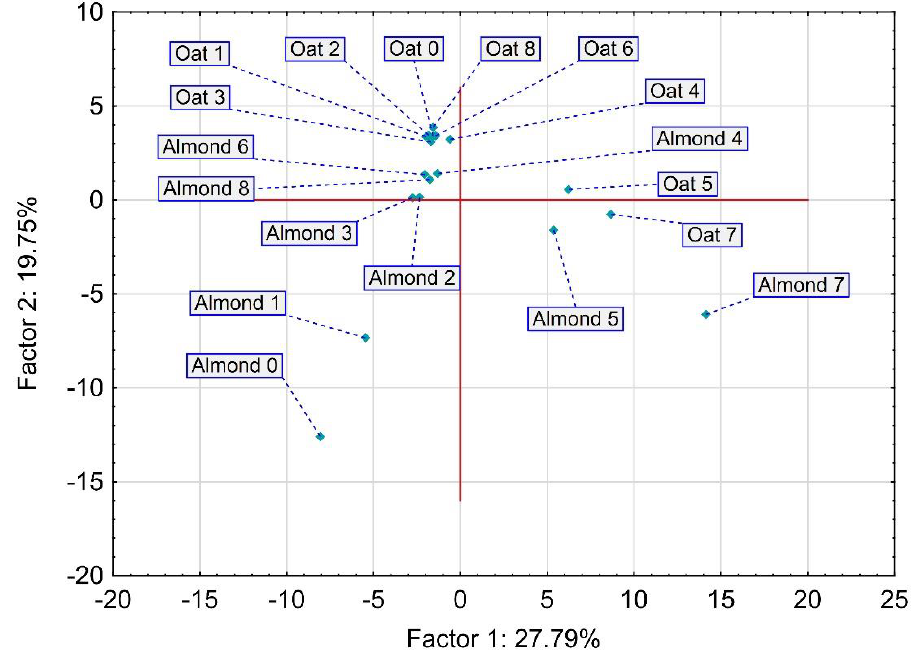
Figure 1. Score plot for principal component analysis (PCA) applied to the volatile compounds of almond and oat beverages (0 — control sample, 1 — L. bulgaricus 27/23, 2 — L. plantarum ATCC 8014,